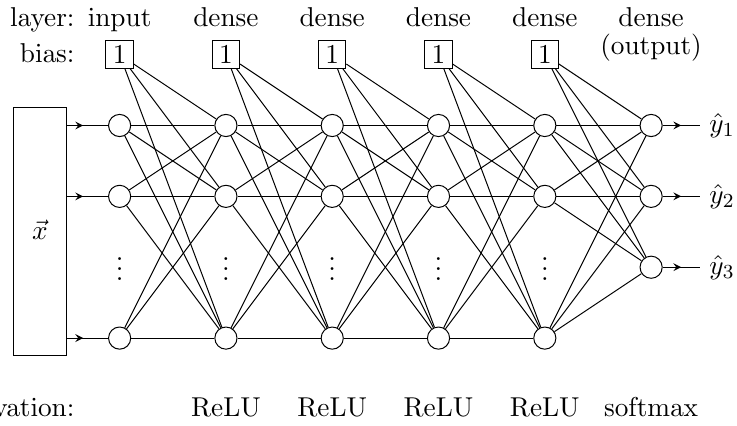
Figure 7 . Schematic diagram of the classi(cid:12)er, including the multilayer perceptron (MLP). The double bordered boxes represent trainable modules.